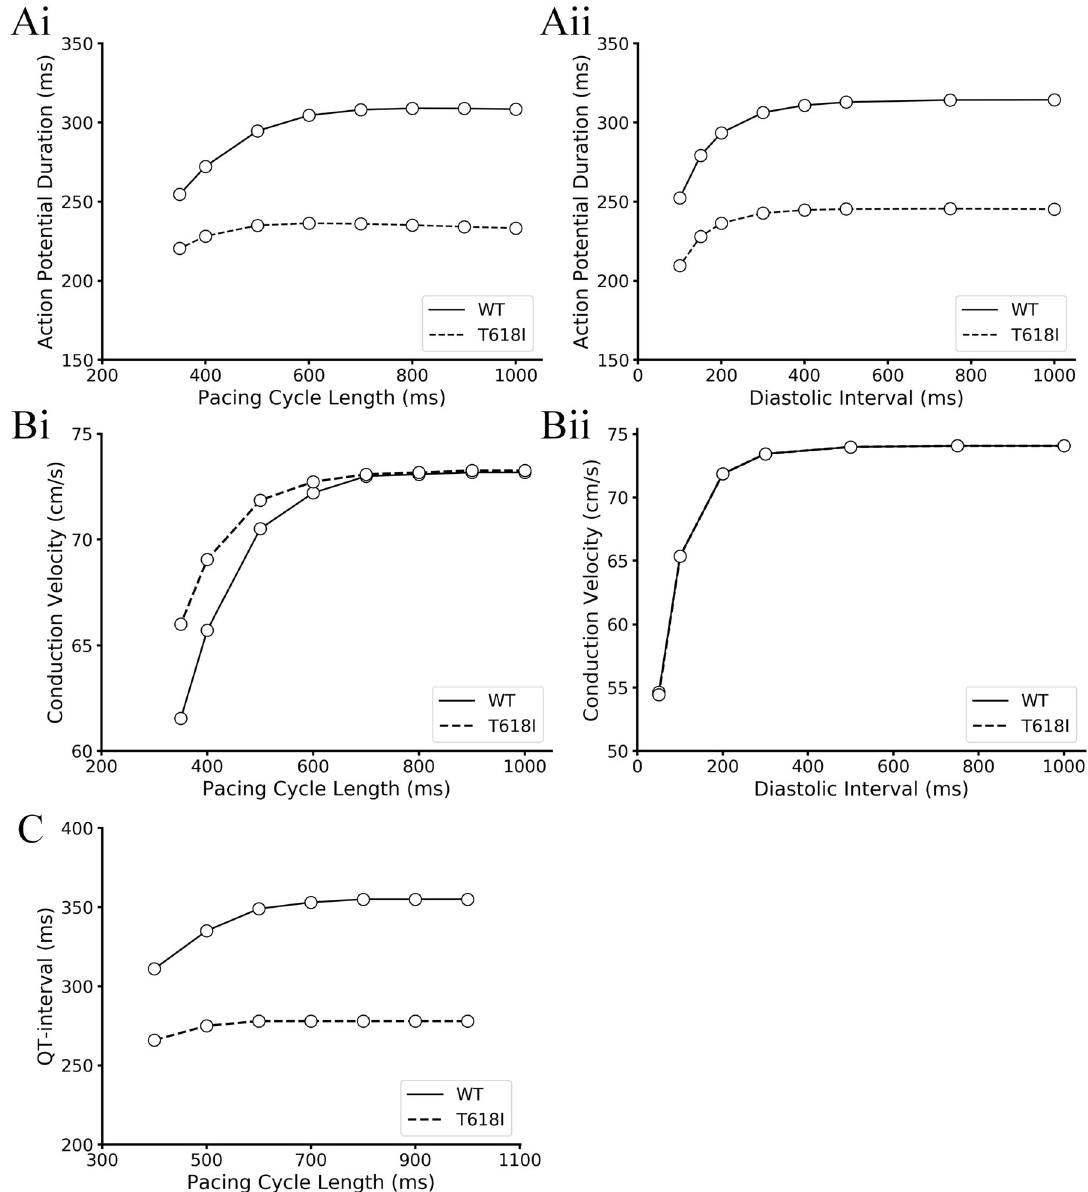
Fig. 2 Simulation results of APD and CV restitution curves and rate adaption curve of QT interval. A APD restitution curves obtained from the S1 – S2 protocol ( Ai ) and the dynamic protocol ( Aii ), where APDs were plotted against PCL and DI, respectively. B CV restitution curves obtained from the S1 – S2 protocol ( Bi ) and the dynamic protocol ( Bii ). C Rate adaption curve of QT